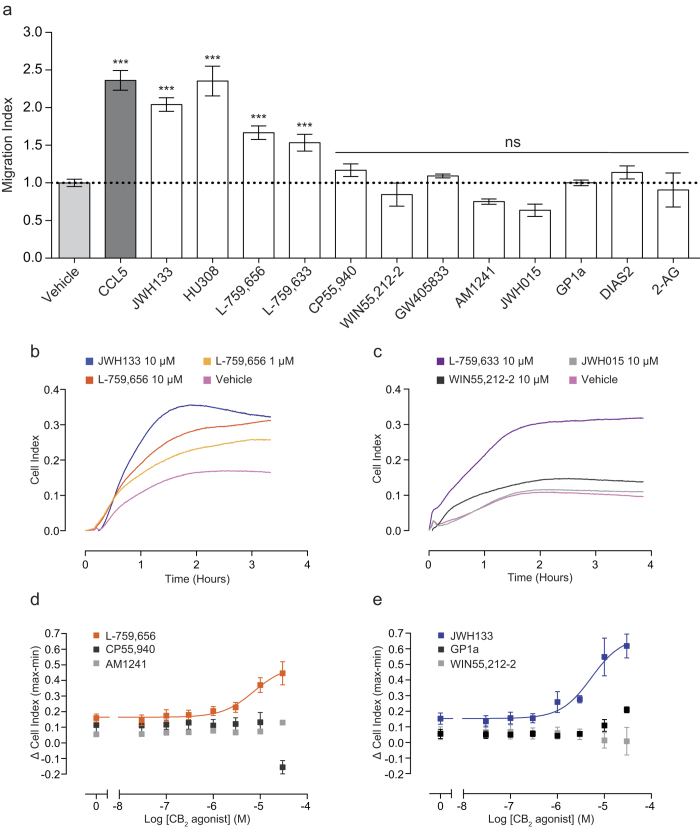
Only a subset of CB2 agonists are primary macrophage chemoattractants. (A-C) Bio-gel elicited murine PECs (4 × 105) were placed into the upper chamber of a CIM-16 plate and allowed to migrate for 3-4 hours at 37 °C, 5% CO2 toward vehicle (0.3% DMSO), 5 nM chemokine or 10 μM cannabinoid. (A) Chemotaxis was measured as maximum cell index minus starting cell index and data are displayed as a fold change compared to cells migrating towards vehicle. Only CCL5, JWH133, HU308, L-759,656 and L-759,633 acted as chemoattractants. 2-AG was used at a concentration of 15 μM. Data are mean ± SEM, n = 3-26 biological replicates with 3-4 technical replicates per condition. (B and C) Representative traces of chemotaxis positive and chemotaxis negative CB2 agonists. Data show mean trace of 3-4 technical replicates per condition. Statistical analysis was conducted by one-way ANOVA with Dunnett’s multiple comparisons correction. ns P > 0.05, *** P < 0.001, comparing all samples to vehicle control. (D,E) Bio-gel elicited PECs (5 × 104) were placed into a 96 well E-plate allowed to adhere for 2-3 hours at 37 °C, 5% CO2. Afterwards, cells were stimulated with either vehicle (0.3% DMSO) or cannabinoid. (D) Concentration response quantification demonstrates that L-759,656 caused cytoskeletal rearrangement in a concentration dependent manner, with an EC50 value of 7.3 μM. In contrast, (D) CP55,940, AM1241, (E) GP1a and WIN55,212-2 failed to elicit a response at any concentration (JWH133 curve is shown for comparison). Data are mean ± SEM, n = 3 biological replicates with 2-3 technical replicates per condition.